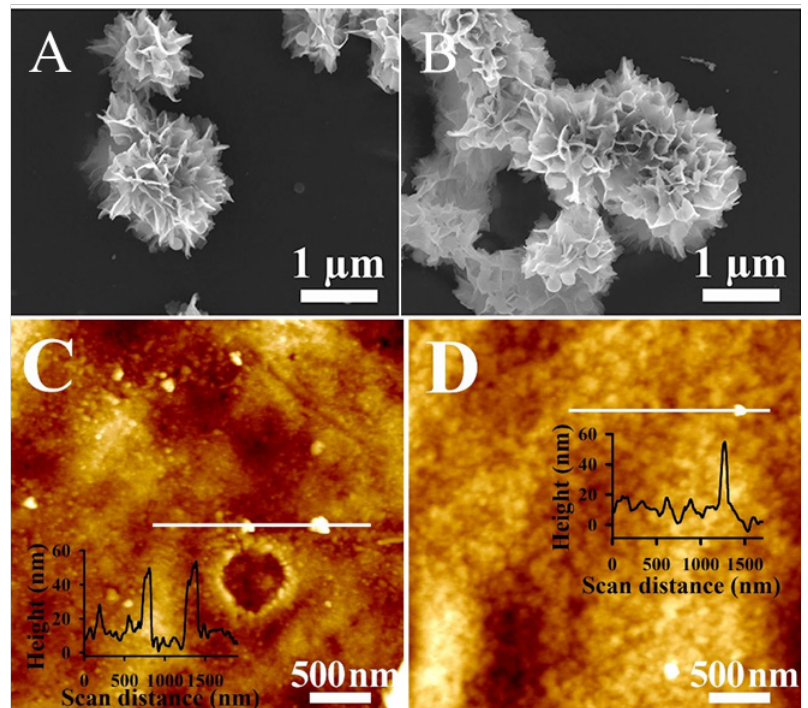
Figure 5. Scanning electron microscopy ( A , B ) and atomic force microscopy ( C , D ) images of poly(styryl bisphosphonate) (poly(StBP))-6, and poly(StBP)-40 ( D ) films, respectively, where “6” and “40” represent the thickness of the Mayer rod (6 and 40 µm) used to spread the polymer solution. (Reprinted with permission from [62] Copyright (2020), Elsevier).